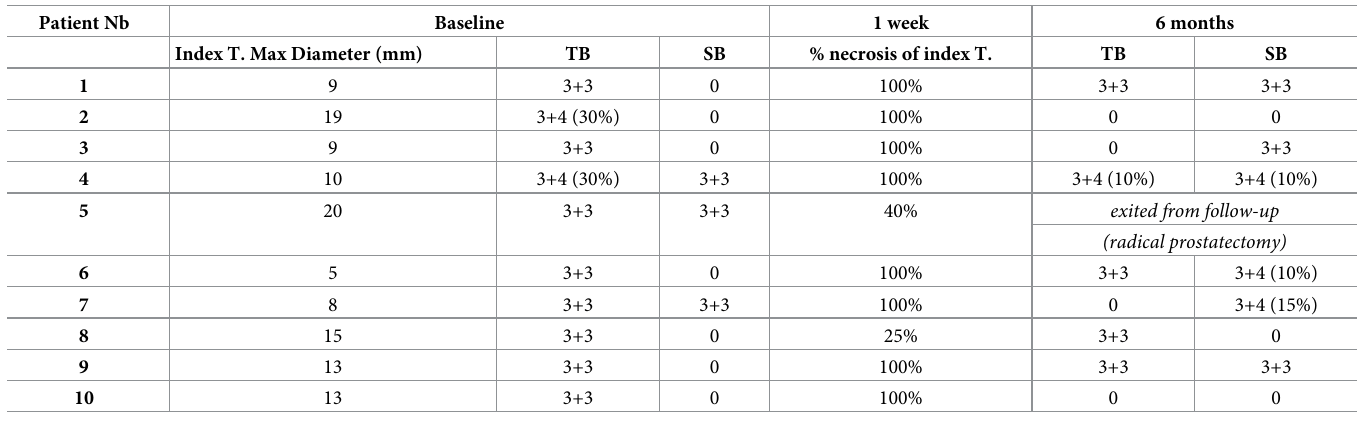
Table 3. Describes the mpMRI and biopsy results of the 10 patients, at baseline, 1 week and 6 months follow-up. Patient Nb Baseline